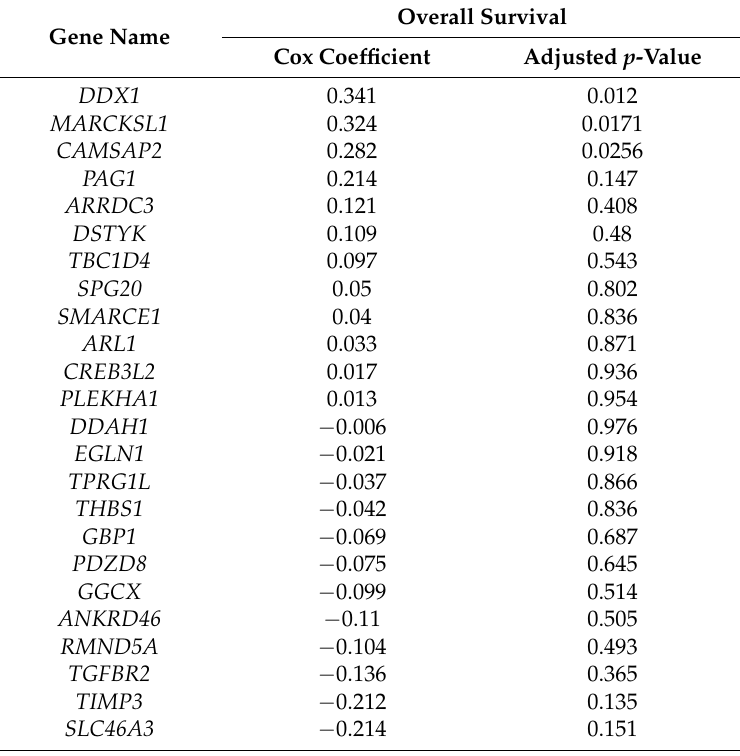
Table 2. Expression of the miR-21 interactome and overall survival in 300 HCC